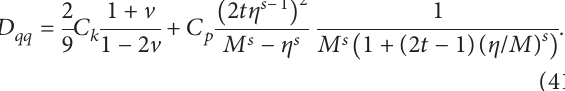
Table 3: Parameter determination